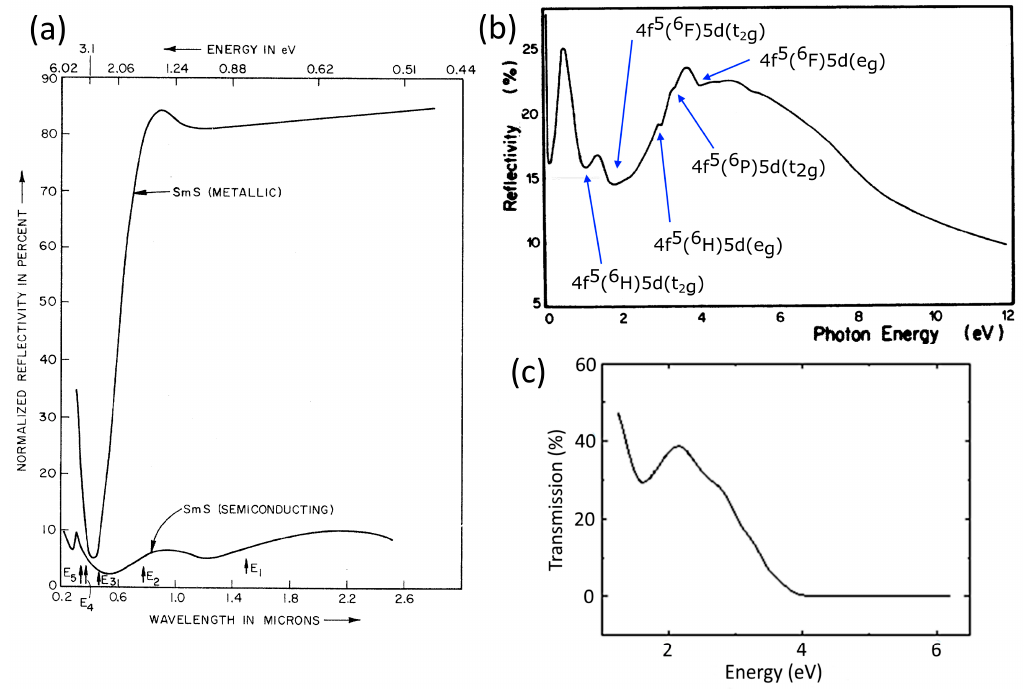
Figure 3. ( a ) SmS reflectivity as a function of wavelength in both metallic and semiconducting phase (SmS single crystal); ( b ) Reflectivity (SmS single crystal) of the semiconducting phase. The final levels of the transitions are labelled in the graph, while all of the transitions start from 4f 6 ( 7 F 0 ); ( c ) Transmission of a 100 nm thin film S-SmS. ((a) and (b) adapted from [39] and [30], respectively, with permission.)